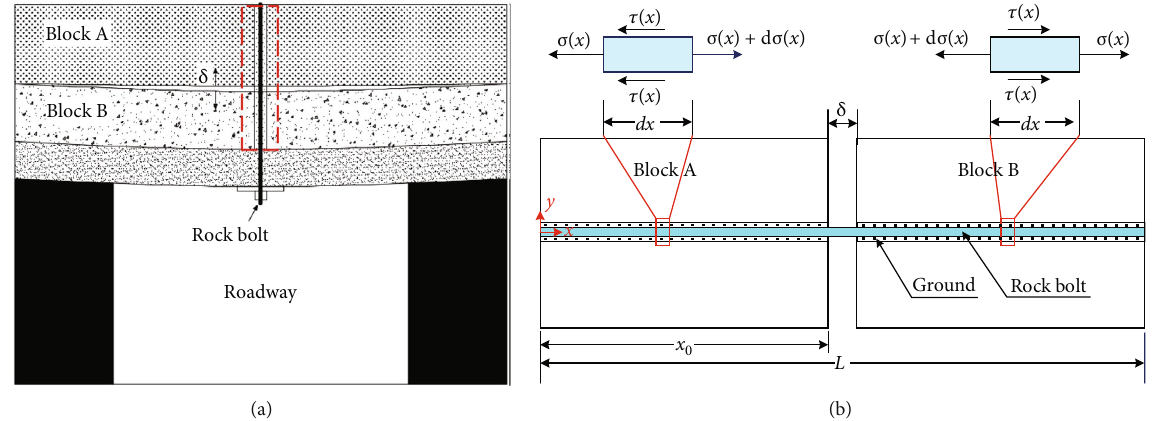
Figure 1: (a) Schematic diagram of roof bedding separation and (b) stress distribution in an elementary length dx